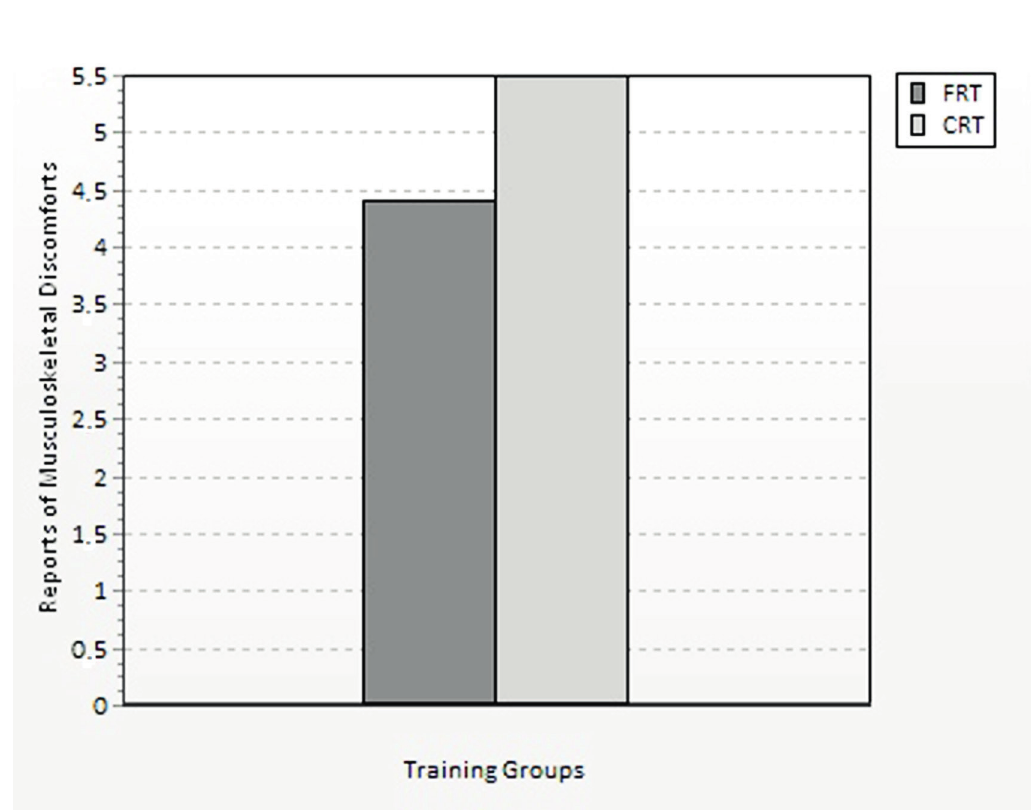
Figure 1 - Mean values of reports of musculoskeletal discomforts per participant according